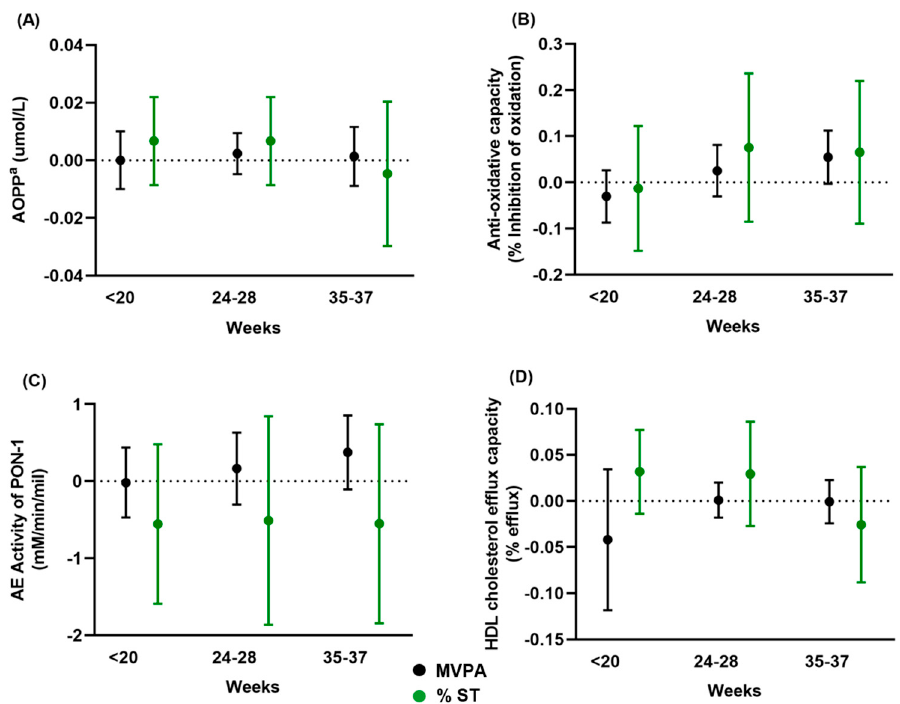
Figure 2. Regression coefficient estimates with 95% confidence intervals of the association between moderate-to-vigorous physical activity (MVPA= black) and % sedentary time (%ST = green) and maternal serum levels of ( A ) advanced oxidation protein products (AOPP), ( B ) serum anti-oxidative capacity (% inhibition of oxidation), ( C ) AE activity of PON-1, and ( D ) HDL cholesterol efflux capacity. a Log transformed values were used in the regression analyses.